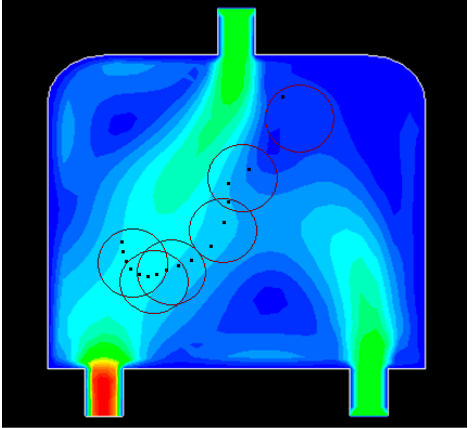
Figure 13. The distribution of events and sensors at t4.